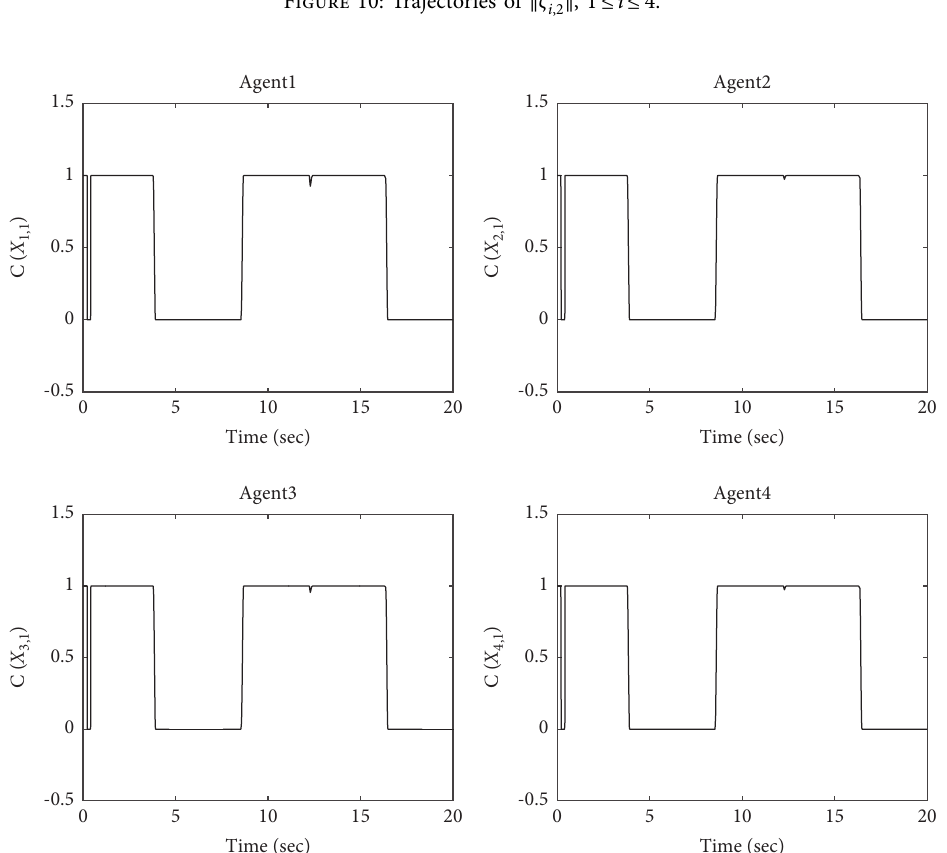
Figure 10: Trajectories of ‖ 􏽢 ζ